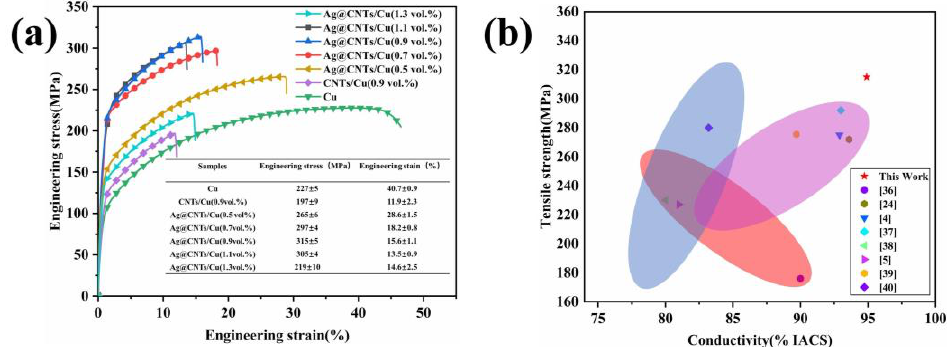
Figure 10. ( a ) Stress – strain curves; ( b ) comparison of tensile strength and electrical conductivity of the CNTs/Cu composites between this work and the other literature [4,5,24,36 – 40] .